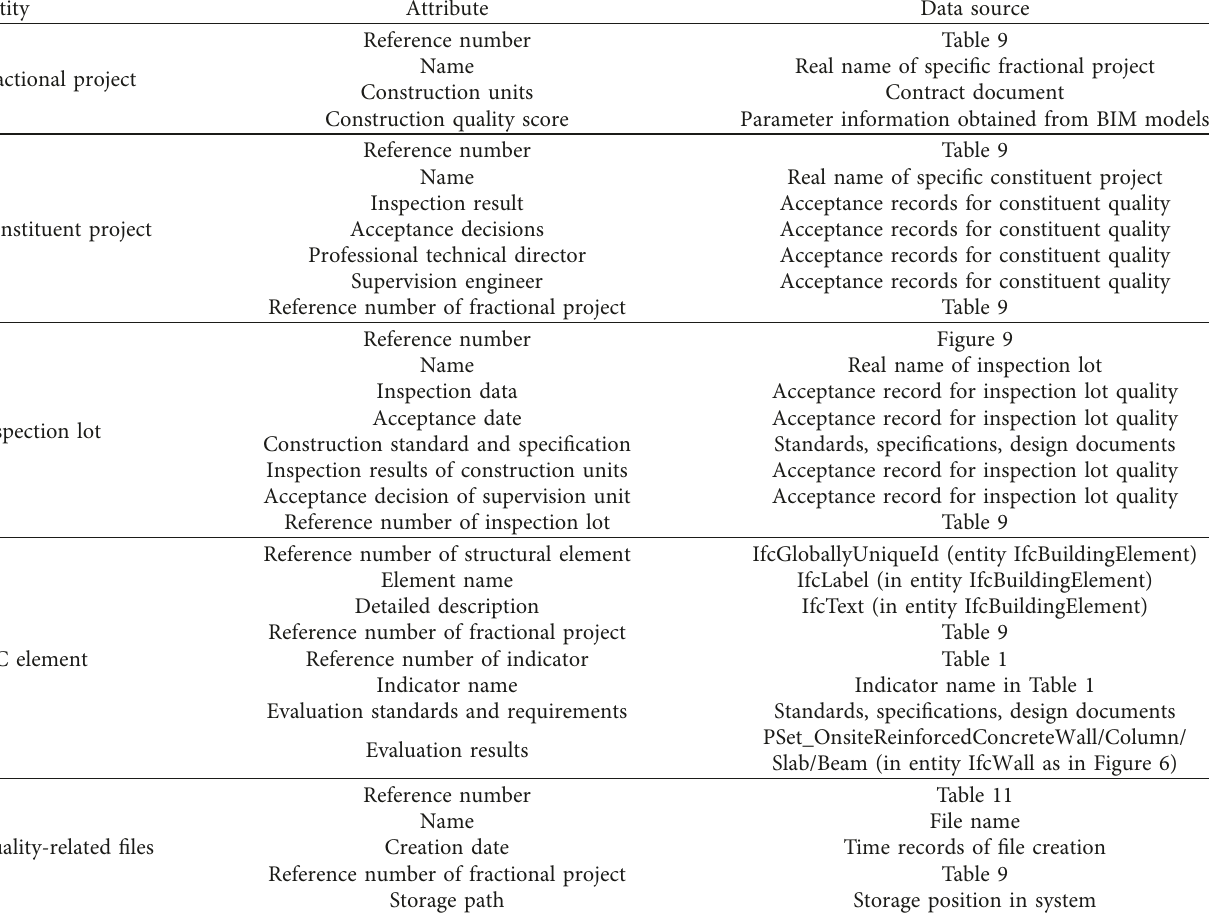
Table 12: Classification of entities and